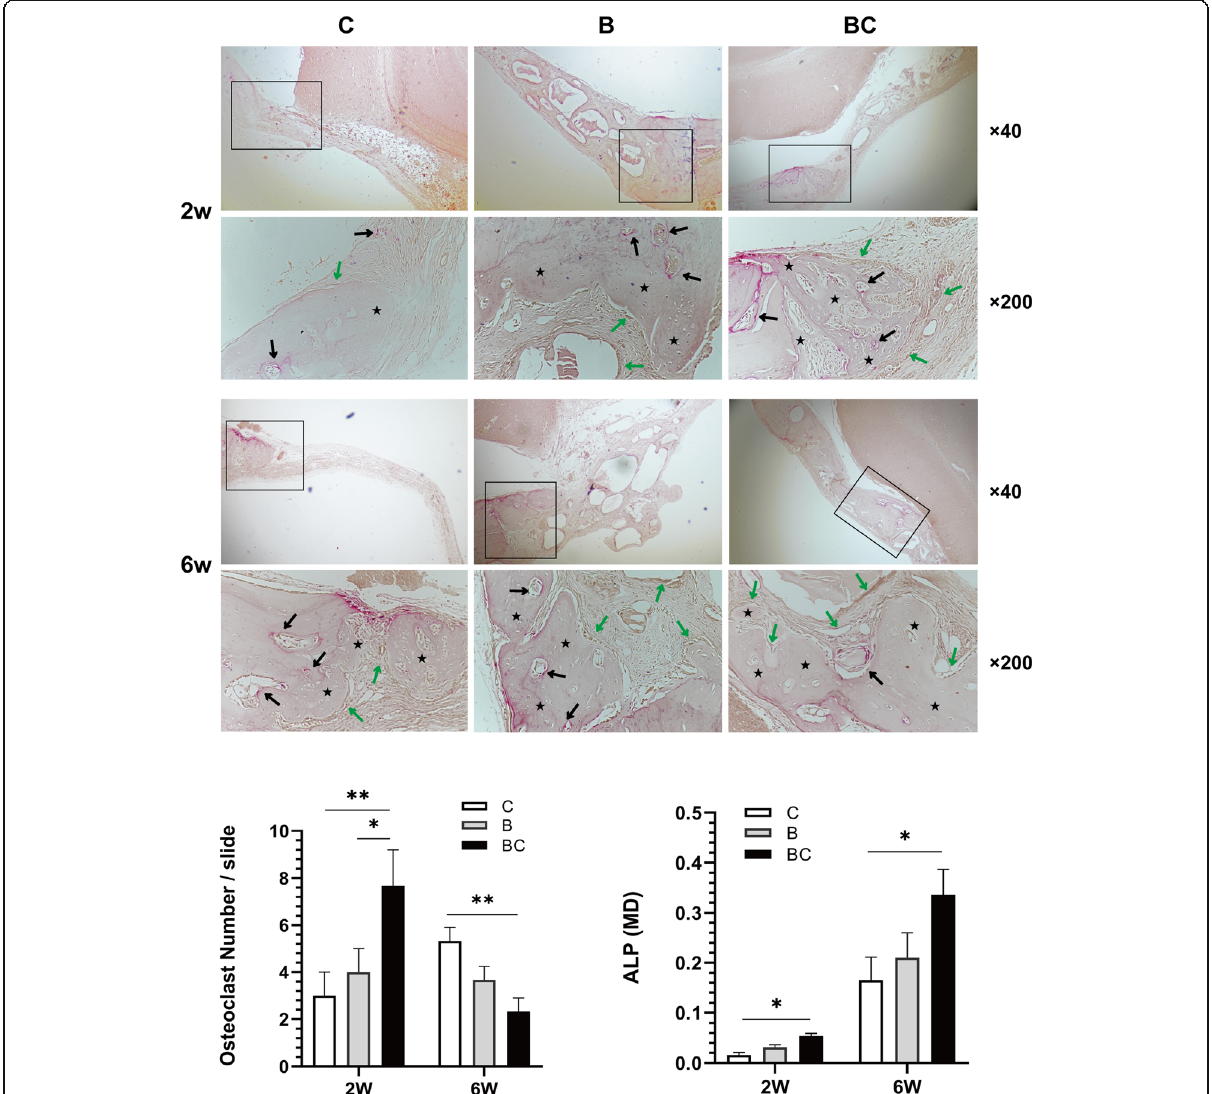
Fig. 5 TRAP/ALP staining analysis. The images were photographed under a light microscope at ×40 and ×200 magnifications. (Black asterisk, new bone tissue; black arrows, TRAP positive osteoclasts which were stained purple; green arrows, ALP-positive osteoblasts which were stained brown) For quantification of TRAP staining, the mean of number of positive cells was determined from three serial sections; for quantification of ALP staining, the mean density (MD) was measured. At 2 weeks, the osteoclast number and the MD of ALP in group BC were significantly higher than that of groups C and B; at 6 weeks, the osteoclast number of group BC was obviously lower than that of groups C and B; conversely, the mean density (MD) of ALP in group BC was significantly higher than C and B groups. * p < 0.05; ** p <